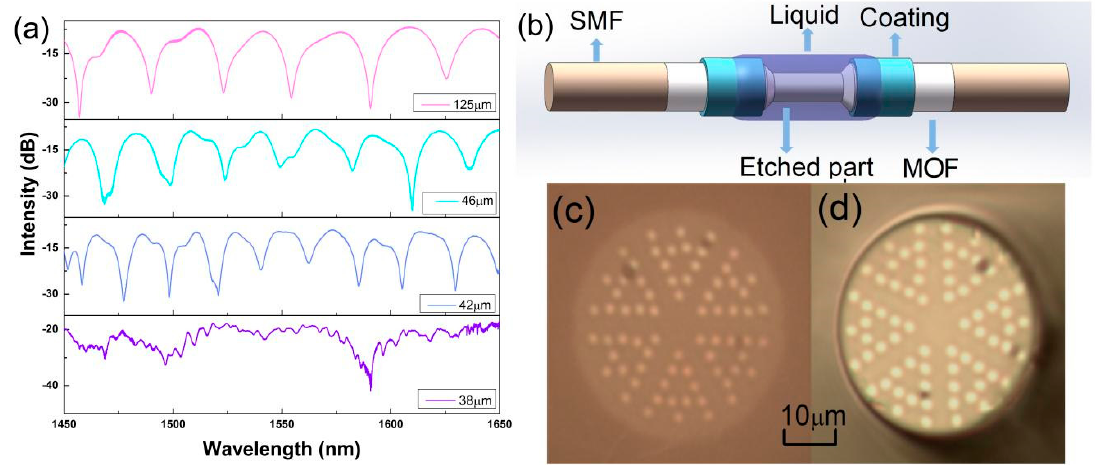
Figure 6. ( a ) The transmission spectra of an unetched MOF and etched MOF with different diameters; ( b ) The schematic diagram of the Mach–Zehnder interferometer (MZI); ( c ) The cross-section of an unetched MOF; ( d ) The cross-section of an etched MOF.